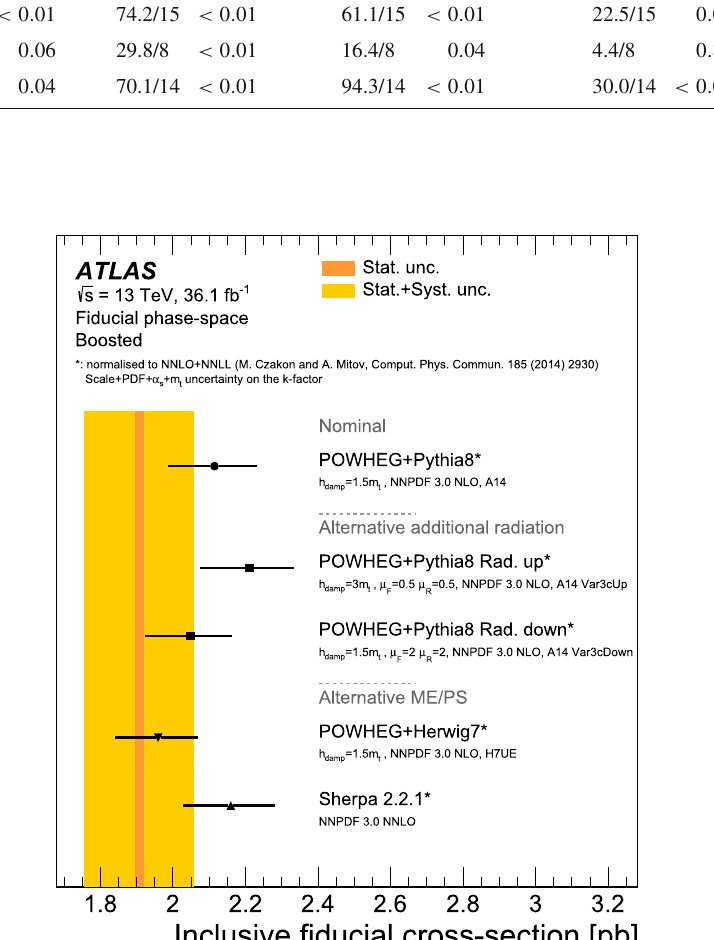
The uncertainty on the cross-section predicted by each NLO MC gen- erator only includes the uncertainty (due to PDFs, m t and α s ) affecting the k -factor used in the